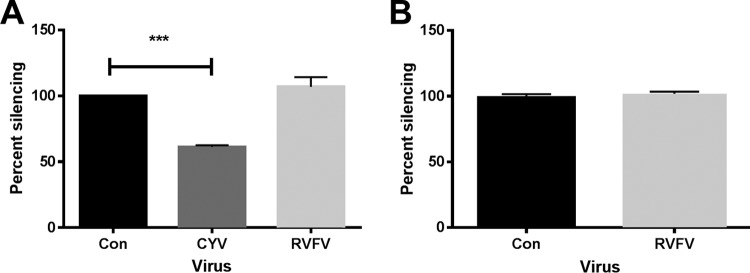
RVFV does not interfere with the exogenous RNAi pathway in mosquito and D. melanogaster cells. (A and B) The effect of RVFV MP12 protein expression on the induction of exogenous RNAi was analyzed using a FLuc reporter system. (A) Aag2 cells were infected with RVFV MP12 or Culex Y virus (CYV) as a control or left uninfected and subsequently transfected with luciferase expression plasmids (pIZ-FLuc as the reporter and pAct-Renilla as an internal control) and dsRNA targeting either FLuc or eGFP control sequences. Values of specific luciferase activity reduction were first normalized against a transfection control, and additional specific FLuc dsRNA-transfected samples were normalized against dseGFP-transfected controls. Effects of virus infection on RNAi induction are presented as percent silencing compared to the noninfected cells. The graph presents means and standard errors of results from three independent experiments performed in triplicate. Statistical analysis was performed using the t test. *, P < 0.05. (B) S2 cells were transfected with luciferase expression plasmids (pMT-Fluc as the reporter and pMT-Rluc as an internal control) and dsRNA targeting either FLuc or eGFP as a control. Cells were then either infected with RVFV MP12 or left uninfected. dsRNA targeting either FLuc or eGFP as a control was added to the cell culture media. The expression of luciferase reporters was induced and quantified. Data were analyzed and presented as described for panel A. The graph presents means and standard errors of results from three independent experiments performed in sextuplicate. Statistical analysis was performed using the t test. *, P < 0.05.